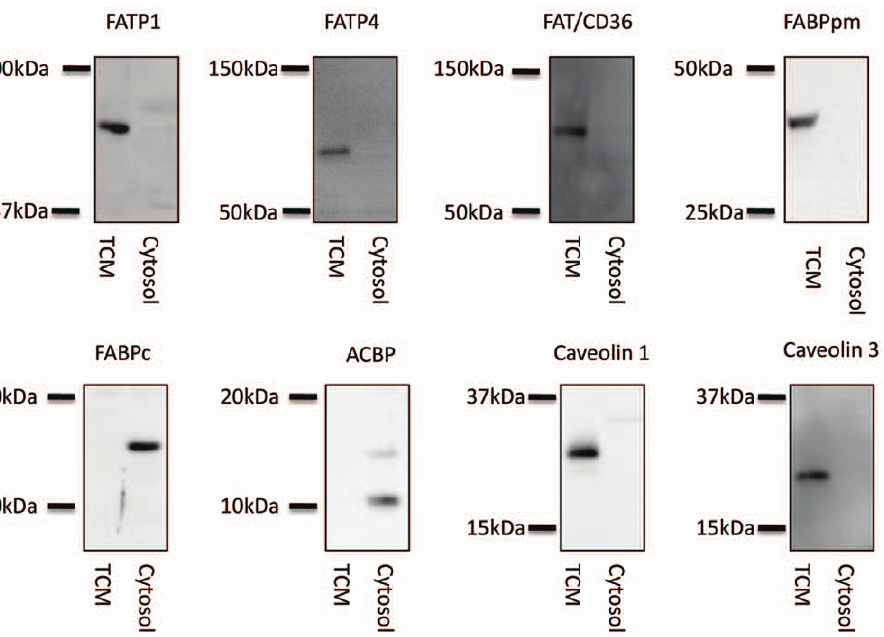
Figure 1. Representative images of the proteins analyzed in total crude membranes (TCM) and soluble cytocolic fractions (Cytosol) from human vastus lateralis muscle are shown. Protein concentration of TCM and cytosol fractions pre- and post training were determined and equal protein amounts were resolved by SDS-PAGE and membranes were immunoblotted using antibodies specific for FATP1; fatty acid transport protein 1 (63 kDa) and FATP4; fatty acid transport protein 4 (72 kDa), FAT/CD36; fatty acid translocase CD36 (88 kDa), FABPpm; membrane bound fatty acid binding protein (43 kDa), FABPc; cytoplasmic fatty acid binding protein (14 kDa), ACBP; acyl-CoA binding protein (10 kDa), and Caveolin 1 (22 kDa), Caveolin 3 (18 kDa). All Western blots were run in parallel with molecular weight markers. Relevant molecular weight markings above and below each analyzed protein are indicated.